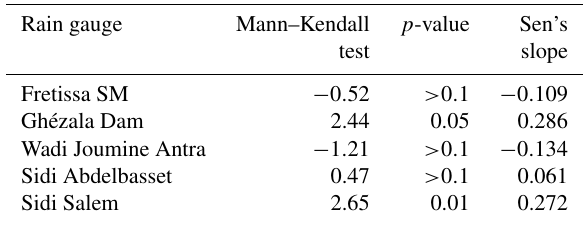
Table 3. Mann–Kendall test and Sen’s slope for the maximum num- ber of rainy days at growing